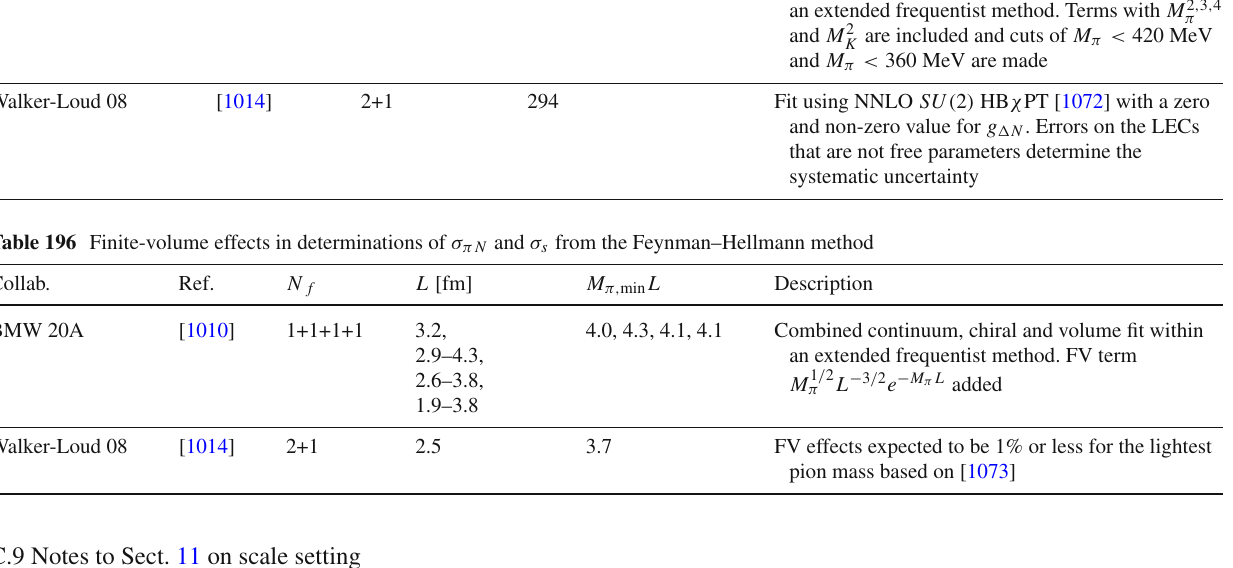
and M 2 are included and cuts of M π < 420 MeV K